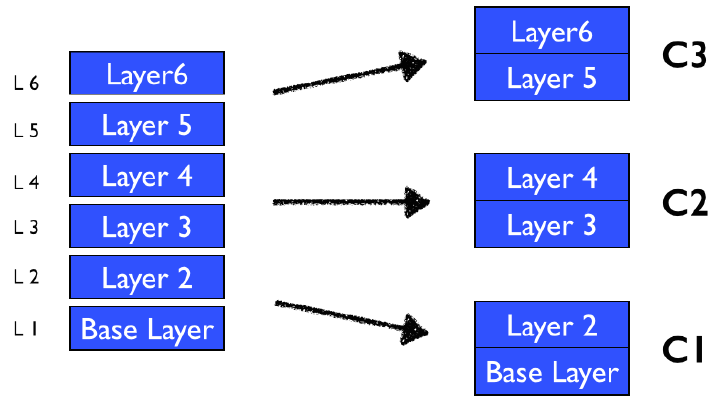
Figure 4. Example of a six-layer SVC stream grouped as three hierarchical